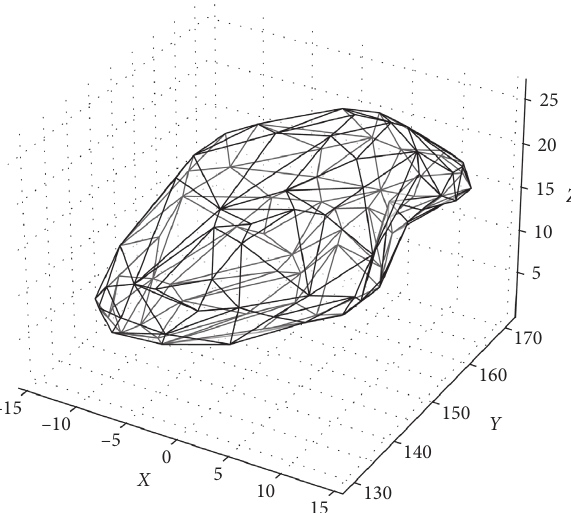
Figure 5: Simplified hematoma